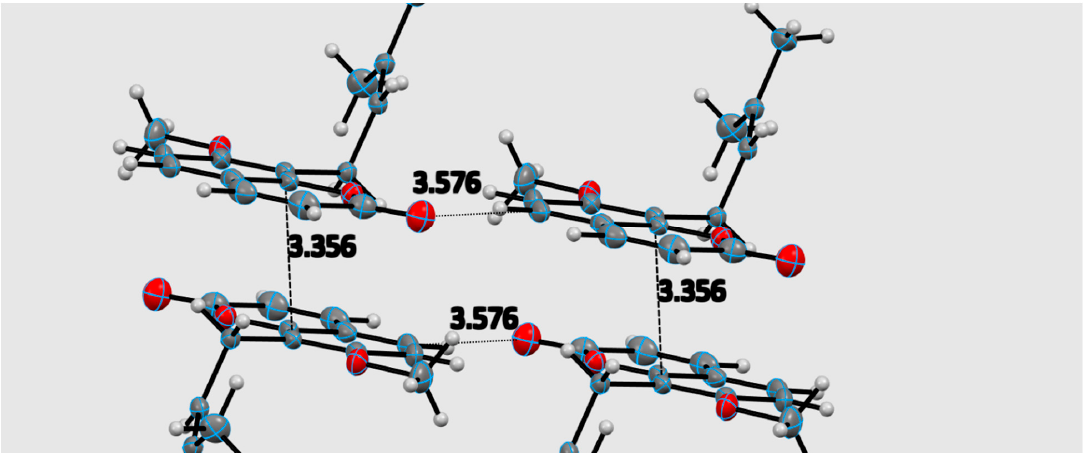
Figure 3. Hydrogen bonding and stacking interactions in osthole crystal structure.